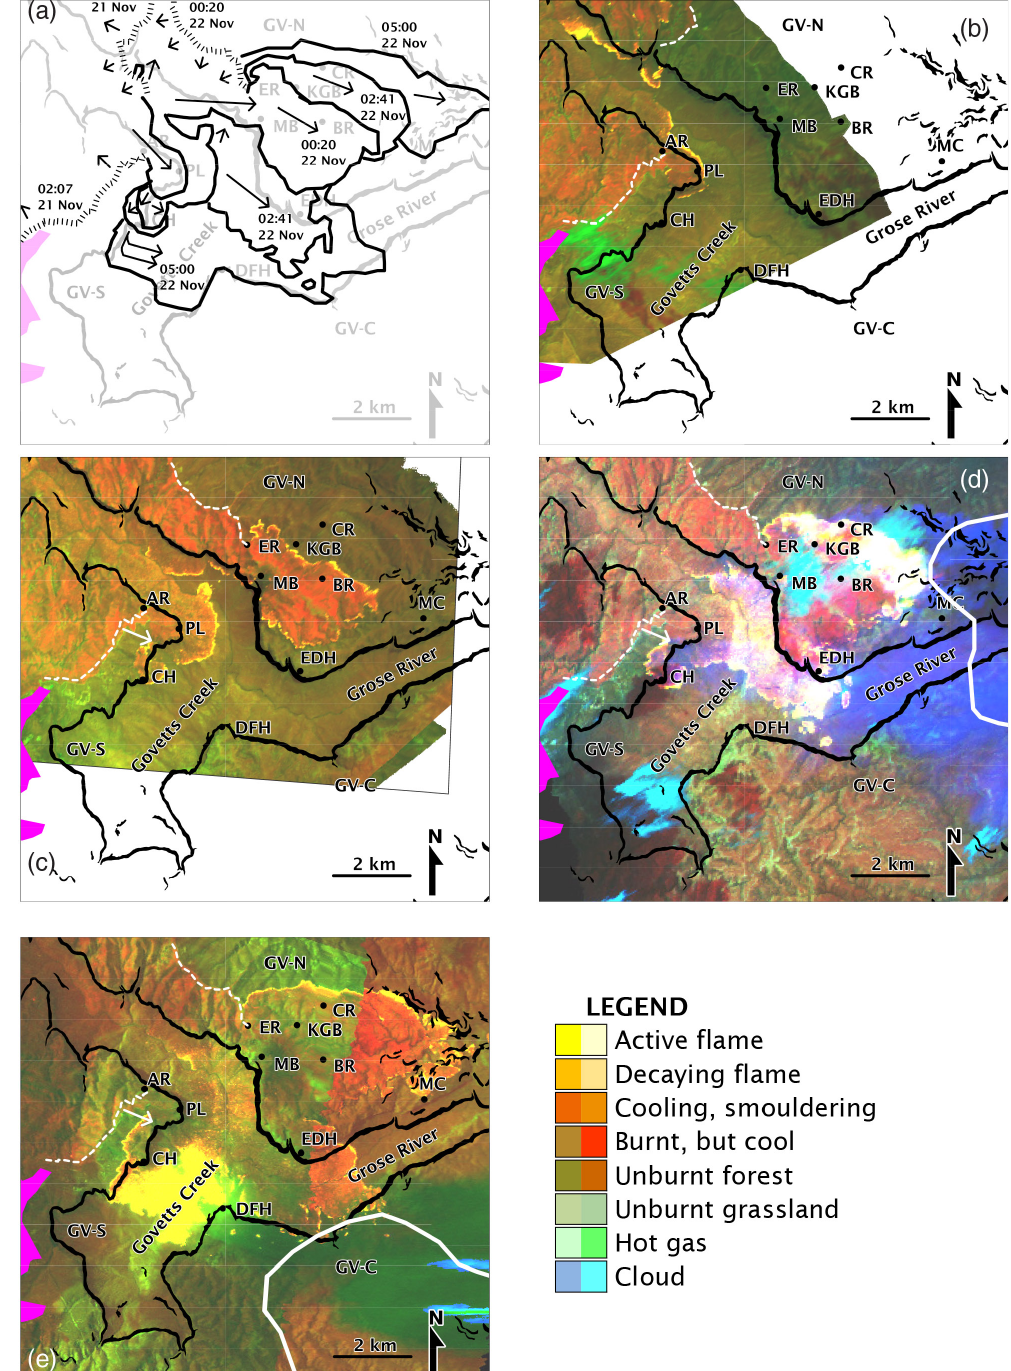
Figure 3. (a) Summary of Grose Valley fire spread dynamics. Arrows show, in a stylised manner, fire spread directions. Cross-hatched lines indicate the control lines that were in place from time to time. ( b, c, d and e ) Line-scan excerpts. Control lines are shown by white dashed lines. (b) Run 116, flown on 21 November, 02:07. (c) Run 117M, flown on 22 November, 00:20. The white arrow near PL is the critical point where fire was able to spread along the cliff top into the GV-S area. (d) Run 126, flown on 22 November, 02:41. The core of the contemporaneous radar reflectivity pattern is outlined in white. (e) Run 127M, flown on 22 November, around 05:00. The core of the contemporaneous radar reflectivity pattern is outlined in white. (Legend) Line-scan thematic legend; note the colours are indicative only, as there is considerable variation due to smoke density. Some colours arise from a composite of surface and atmospheric